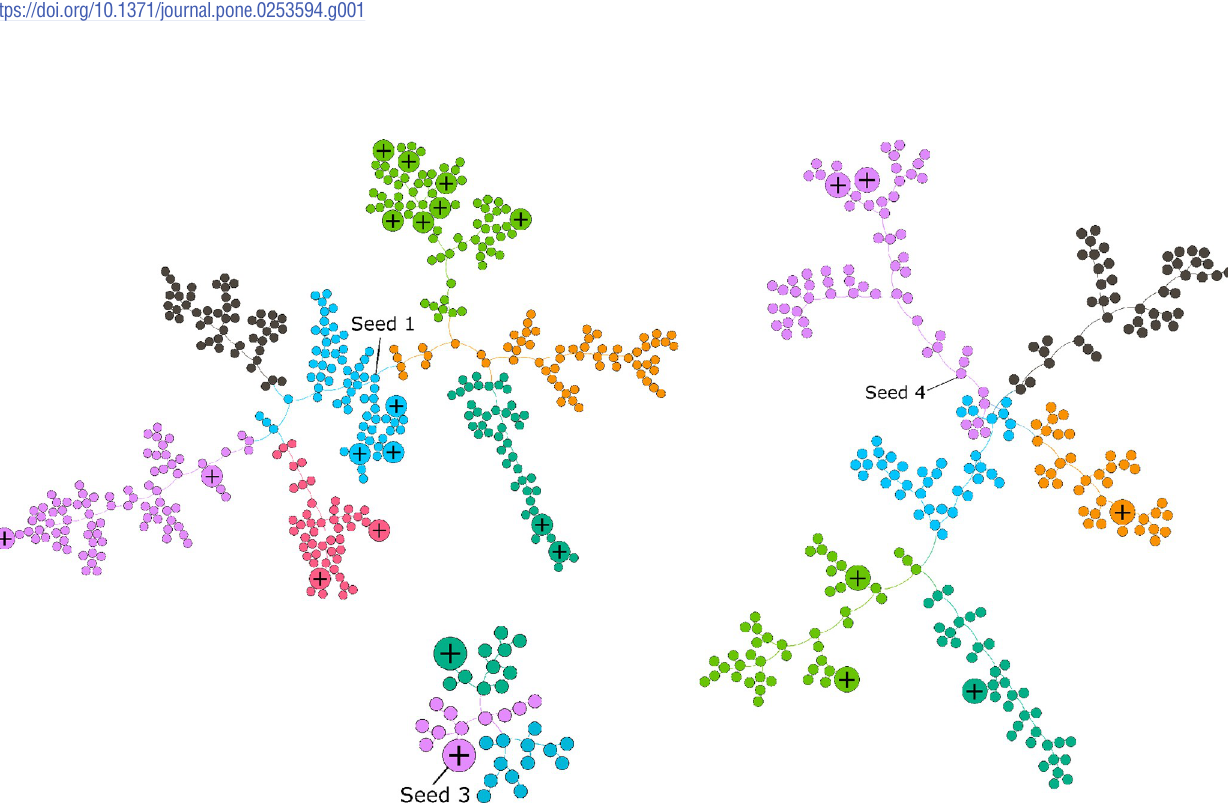
PLOS ONE | https://doi.org/10.1371/journal.pone.0253594 July 22, 2021 8 /